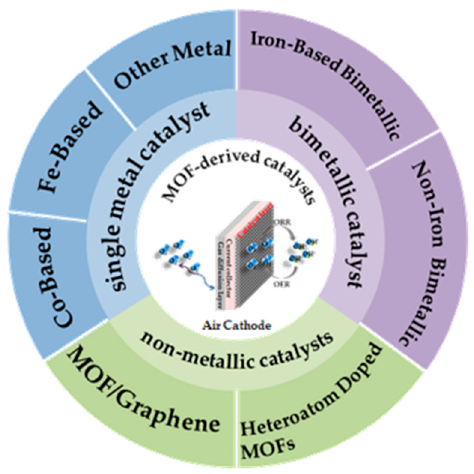
Figure 3. Classification diagram of MOF-derived catalysts for air cathode in Zn–air battery.